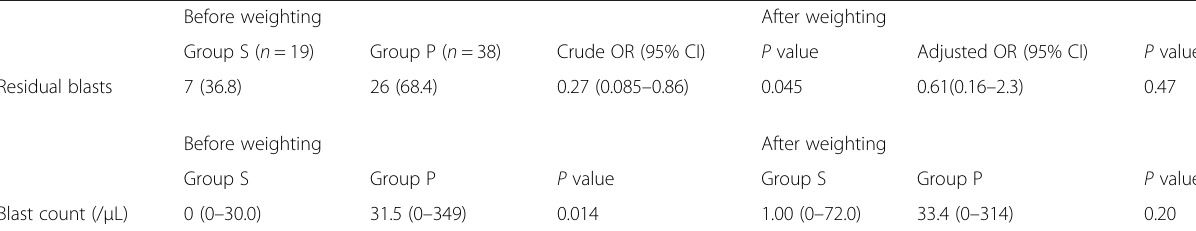
Table 2 Relationship between the anesthesia method and the presence of residual blast cells in peripheral blood by inverse probability of treatment weighting (IPTW) using propensity score Before weighting After